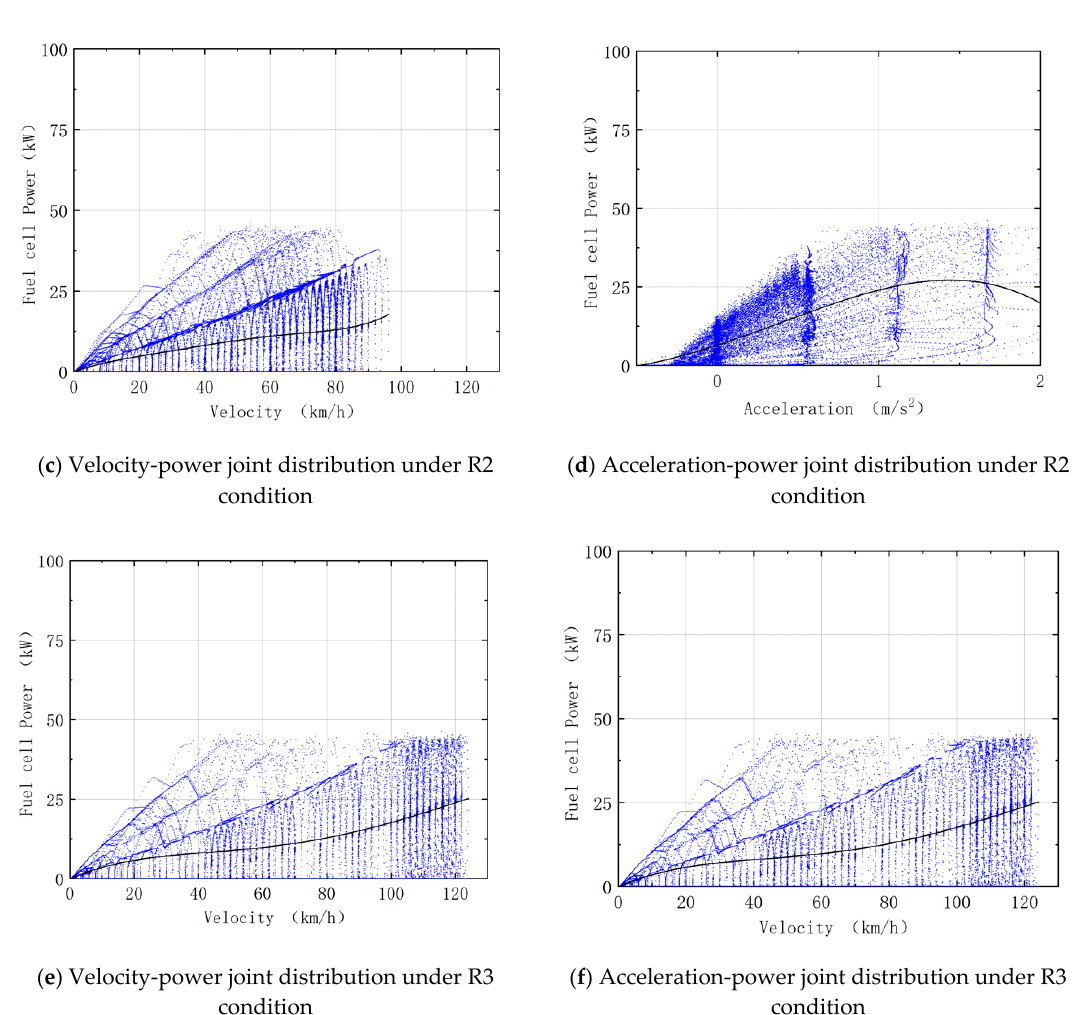
Figure 12. Joint distribution of velocity, acceleration and power of FCV under three real-world driving cycles.